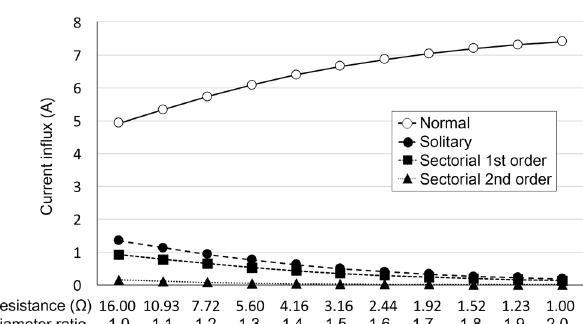
Figure 4. Changes in electric current influx into a hexagon due to change in boundary resistance. When the resistance of the boundary is lower, more currents flow normally, but to a lesser degree in the disconnected